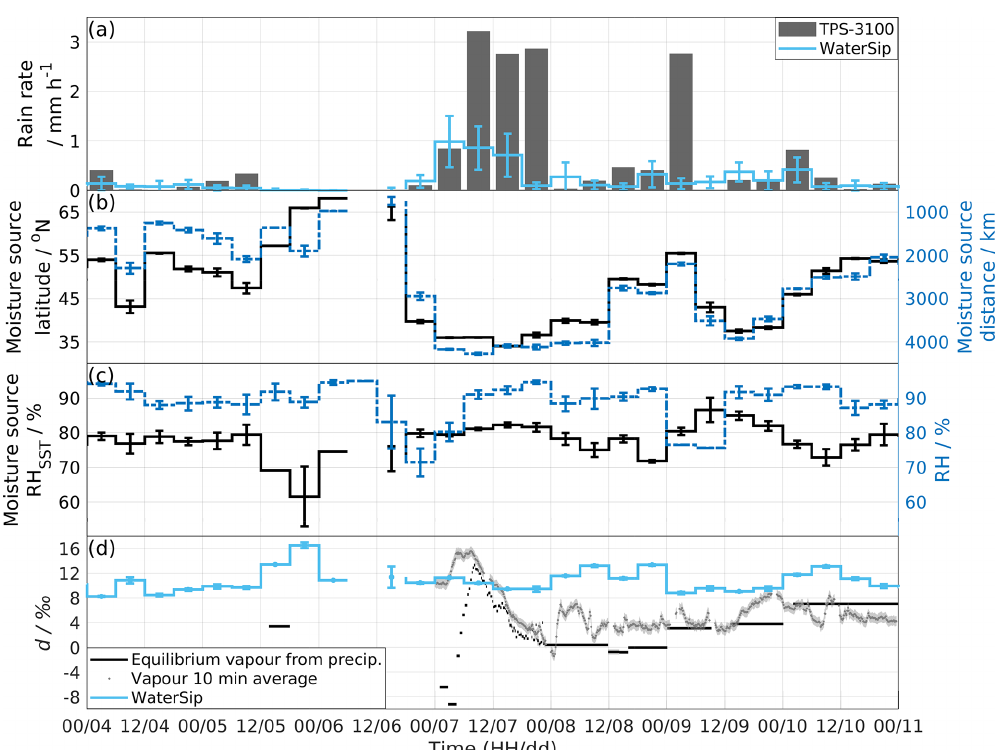
Figure C1. The 7d time series of observations at the sampling site and Lagrangian diagnostic (WaterSip) output for the Bergen region between 00:00UTC 4 December and 00:00UTC 11 December 2016. (a) The 6-hourly averaged rain rate observed from the total precipitation sensor (grey shading) and estimated rain rate from WaterSip (blue line). (b) Moisture source latitude (solid black line) and source distance (dashed blue line) estimated by WaterSip. (c) Moisture source RH SST estimated by WaterSip (solid black line) and 6h averaged RH at the sampling site (dashed blue line). (d) d -excess of the 10min averaged vapour (grey dots), of the equilibrium vapour from precipitation (black segments) at 45m above ground, and WaterSip estimate (light blue). The width of the black segment indicates the period over which the precipitation sample was collected. The uncertainties are 0.83‰ and 0.20‰ for d -excess of vapour and the equilibrium vapour from precipitation, respectively. The error bars in (a–d) indicate 1 standard deviation. The missing data of the WaterSip at 12:00UTC 6 December are due to bad data quality. The observation of d -excess is only available from 7